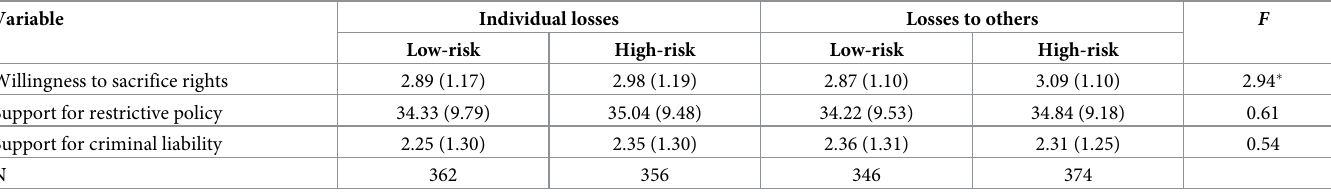
Table 7. Group means of experimental conditions in a completely randomized 2x2 factorial design.